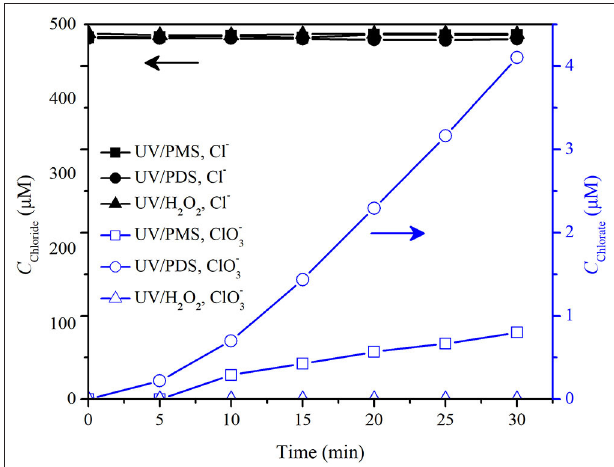
FIGURE 8 | Concentrations of chloride and chlorate in UV/PMS, UV/PDS, and UV/H 2 O 2 . Conditions: [PMS] = 200 µ M as 1/2 Oxone, [PDS] = 200 µ M, [H 2 O 2 ] = 200 µ M, unbuffered, I 0 = 1.92 µ Einstein · s − 1 , V = 0.55L, 20 ◦